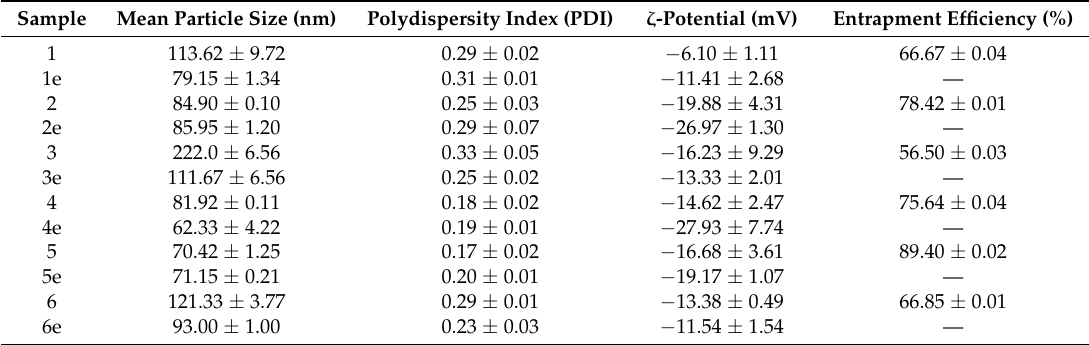
Table 2. Physicochemical characteristics of liposomal